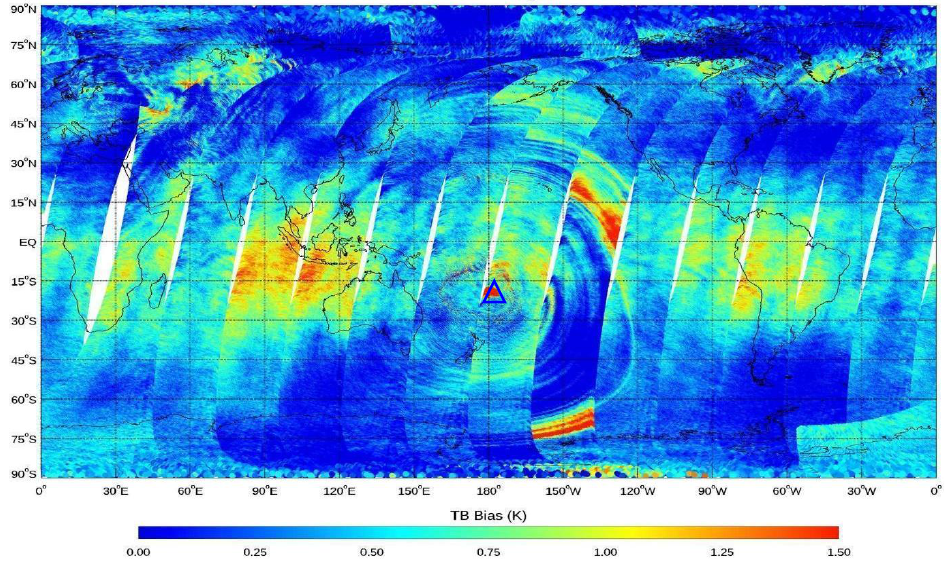
Figure 5. NOAA-20 descending node CrIS FSR O- B global bias map at 14.93 μm on 15 January 2022.